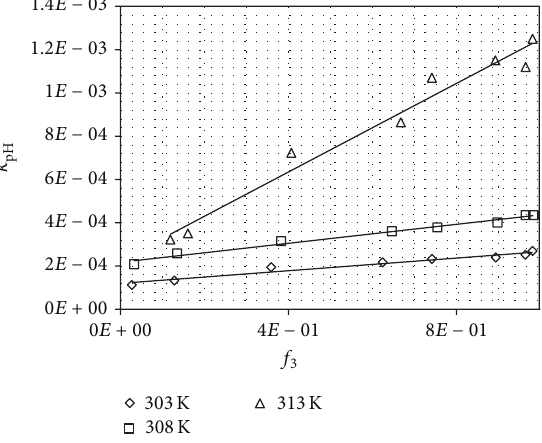
Figure 3: Plots 𝑘 solutions. Figure 4: Plots 𝑘 󸀠